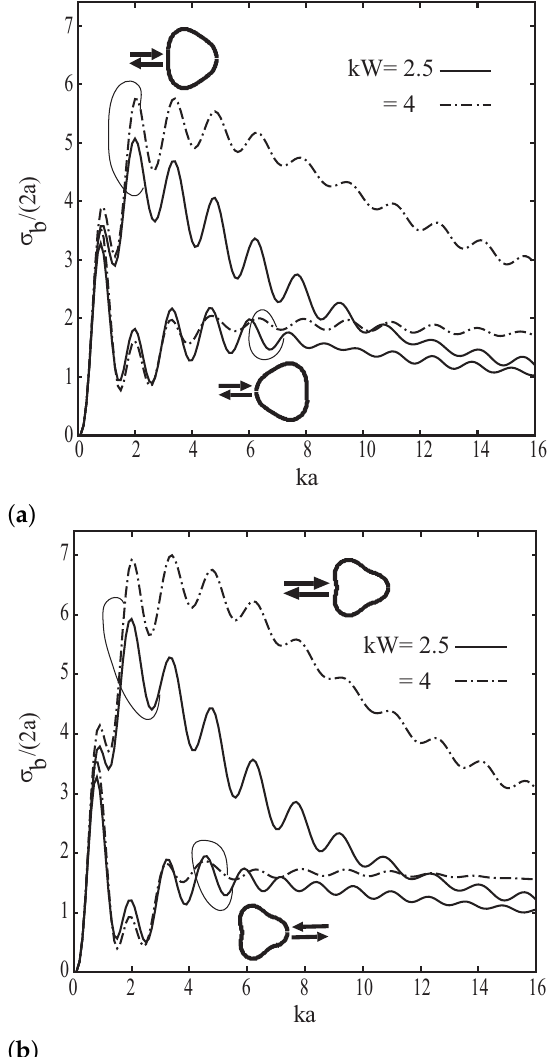
Figure 7. Target size versus LRCS in a disordered medium for SCL = 30 where ( a ) δ = 0.08, ( b ) δ =